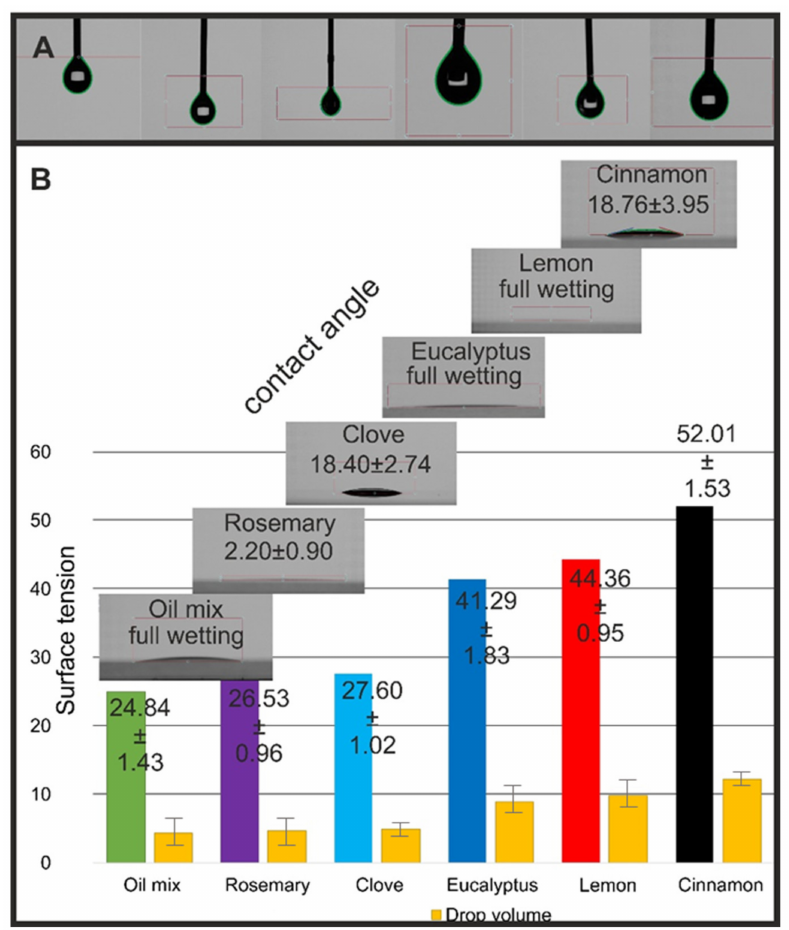
Figure 7. ( A ) EO droplets during surface tension measurements. ( B ) EO contact angle, surface tension, and droplet volumes